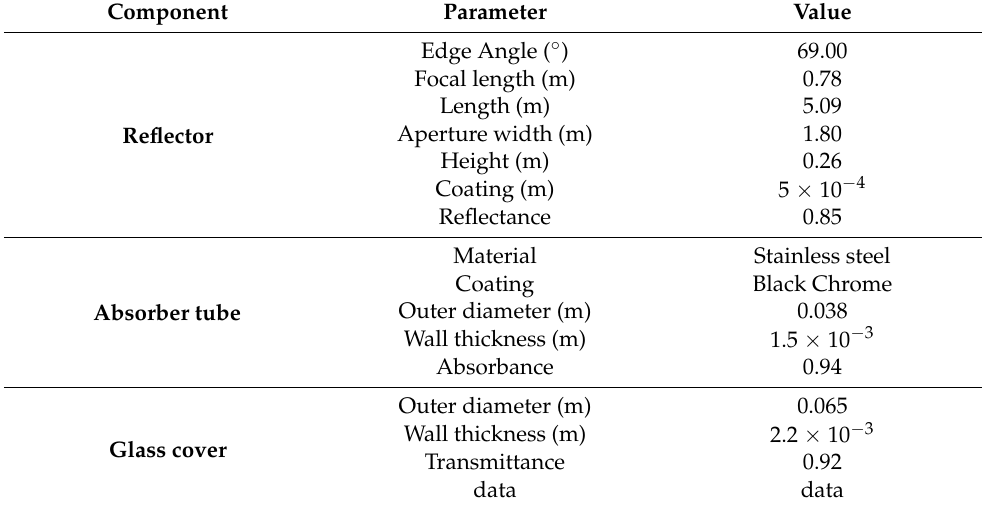
Table 1. Characteristics of the PTC-1800 collector.